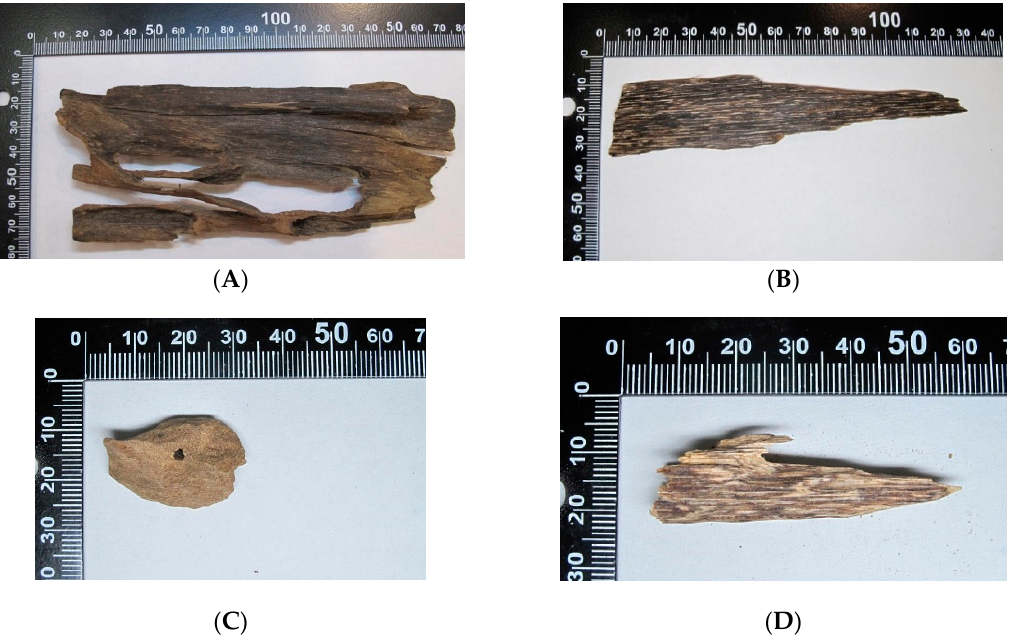
Figure 1. Morphological observation of Kynam ( A ), Vietnam ( B ), Liao ( C ), and Cambodian agarwoods ( D ).